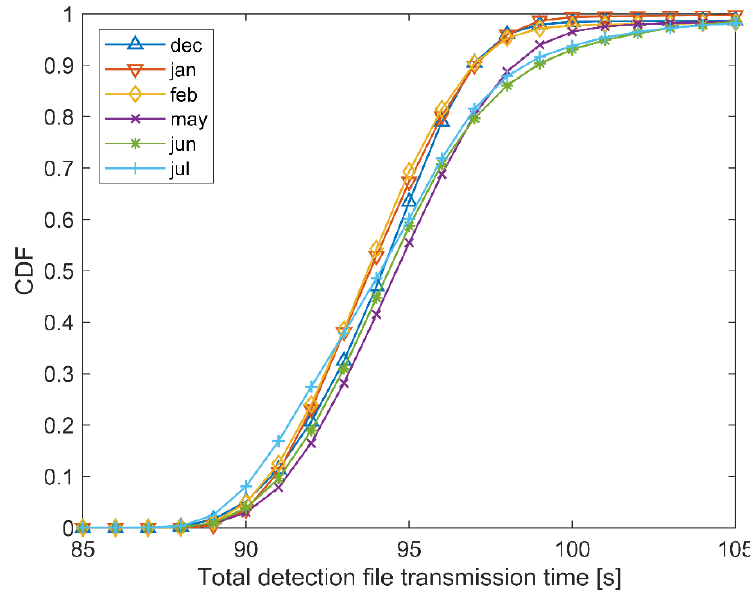
Figure 15. CDF for detection file size range 15 – 25 kB.